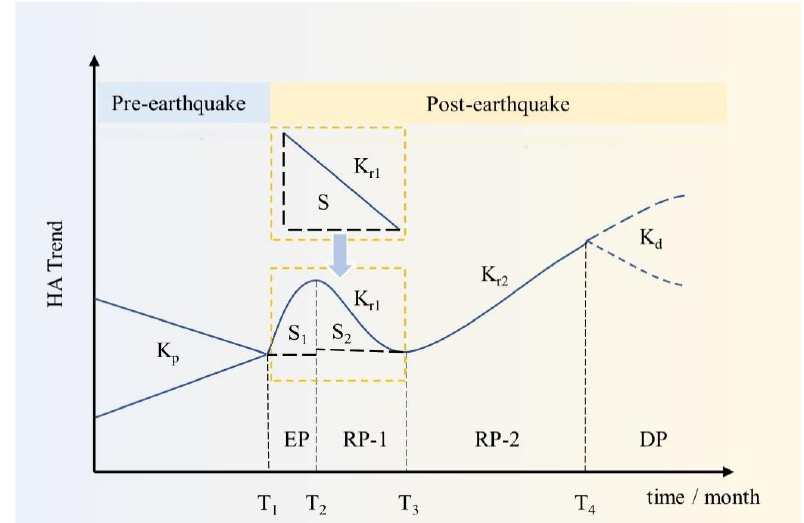
Figure 3. PNLP pattern. T1 represents the month of the earthquake; EP, RP-1, RP-2, and DP represent the emergency phase, recovery phase, reconstruction phase, and development phase, respectively; the defined PNLP indicators include k p , k r1 , k r2 , k d , and S. At a certain period before the earthquake, according to the regional development situation, the intensity of HA increased or decreased linearly. The first post-earthquake phase is defined as the emergency phase (EP), which takes a relatively short period of time, with a sudden increase in the intensity of HA. The second phase after the earthquake is defined as the recovery phase (RP-1), in which emergency relief measures are gradually withdrawn, resettlement services gradually stabilize, and the intensity of HA gradually decreases. The third stage is defined as the reconstruction stage (RP-2). In this stage, a series of work, such as life reconstruction, is carried out and the intensity of HA gradually increases. The fourth stage is defined as the development phase (DP), which may show different characteristics, that is, it may continue to develop on the basis of the reconstruction stage, or the intensity of HA enters a decline stage at a certain period after reconstruction. PNLP pattern (Figure 3) describes various post-earthquake stages. The data we employed in this study are monthly data, however, as we know, the EP takes 24 hours to 2 weeks [50]. Therefore, this pattern may not detect the EP changes, so EP and RP-1 based on monthly data are defined as phases (from the earthquake month to the lowest HA level). The speed and the quality of recovery process must be monitored [51]. From Figure 3, we know that the PNLP pattern was divided into two parts: pre-earthquake and post-earthquake. We developed the K p (pre-earthquake development rate), which reflects the changing levels of HA intensity before the earthquake. K r1 (recovery rate) reflects the changing levels of HA intensity in RP- 1. K r2 (reconstruction rate) reflects the changing levels of HA intensity in RP-2. K d (development rate) reflects the changing levels of HA intensity in DP. K rp (relative reconstruction rate) is a relative quantity, and it reflects the changing levels of HA intensity relative to the pre-earthquake HA level. S (loss) reflects the amount of HA loss during the EP and RP-1. In order to better analyze the changes in HA at various stages, we defined the parameters in Table 1.